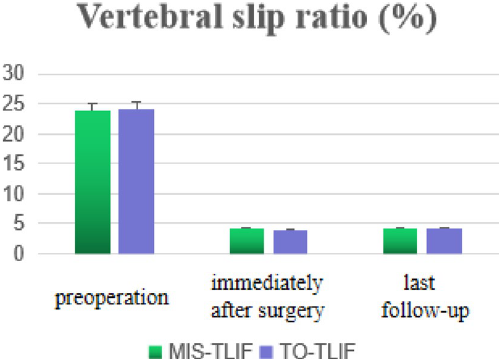
Figure 5. Histograms for vertebral slip ratio between MIS-TLIF and TO-TLIF groups.